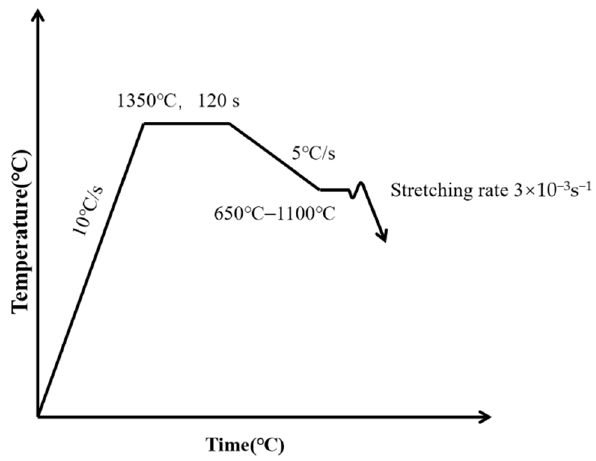
Figure 2. Hot tensile test scheme.